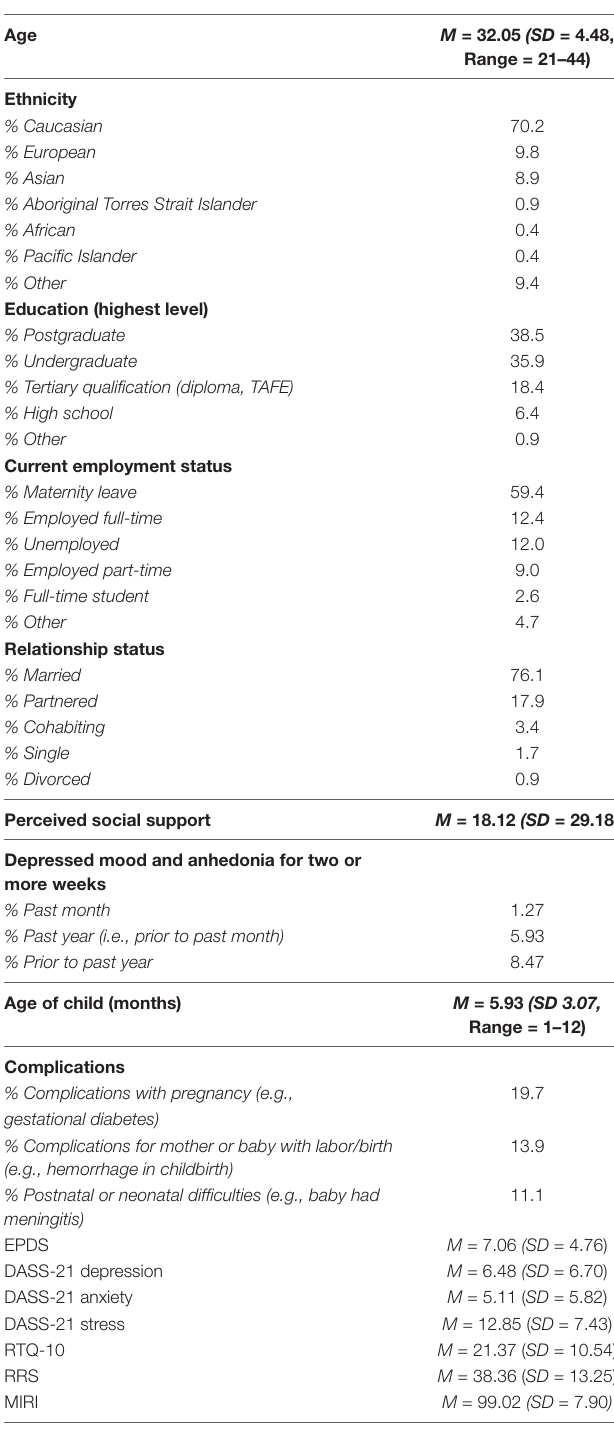
TABLE 1 | Participant characteristics ( N =